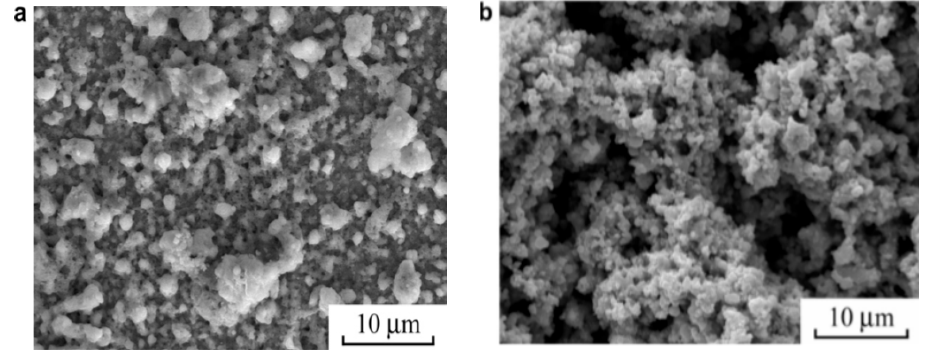
Figure 13. Surface morphology of an LSM cermet cathode deposited by ( a ) aqueous solution (reproduced with permission from [24], Elsevier, 2011) and ( b ) ethanol (reproduced with permission from [29], Elsevier, 2012) SPPS.